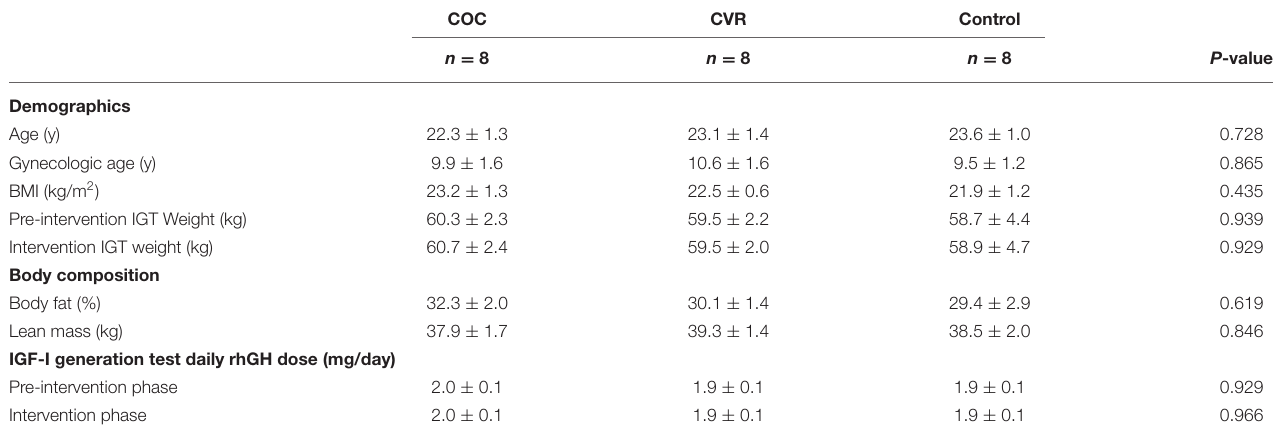
TABLE 1 | Participant demographic and body composition characteristics by study group.